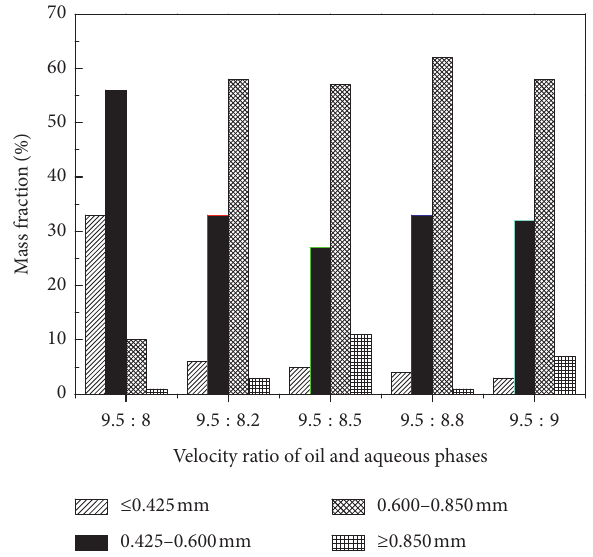
Figure 9: Effect of different velocity ratios of oil and aqueous phases on crystal size distribution.